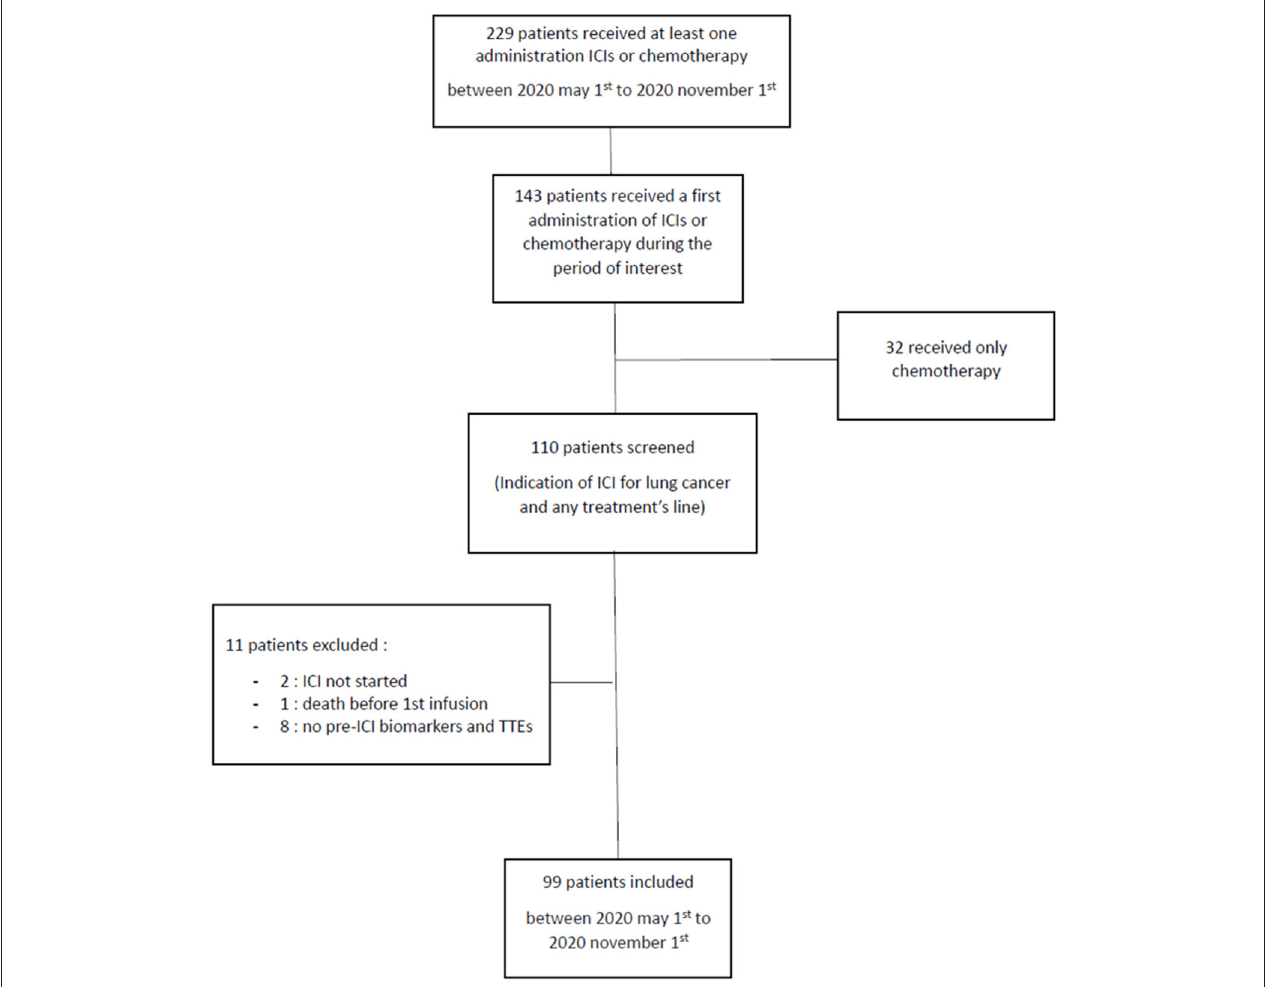
FIGURE 1 | Flow chart. ICI, immune checkpoint inhibitors; TTE, transthoracic